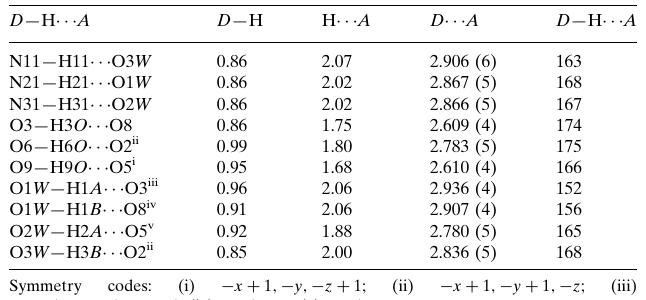
Hydrogen-bond geometry (A˚ , (cid:2)